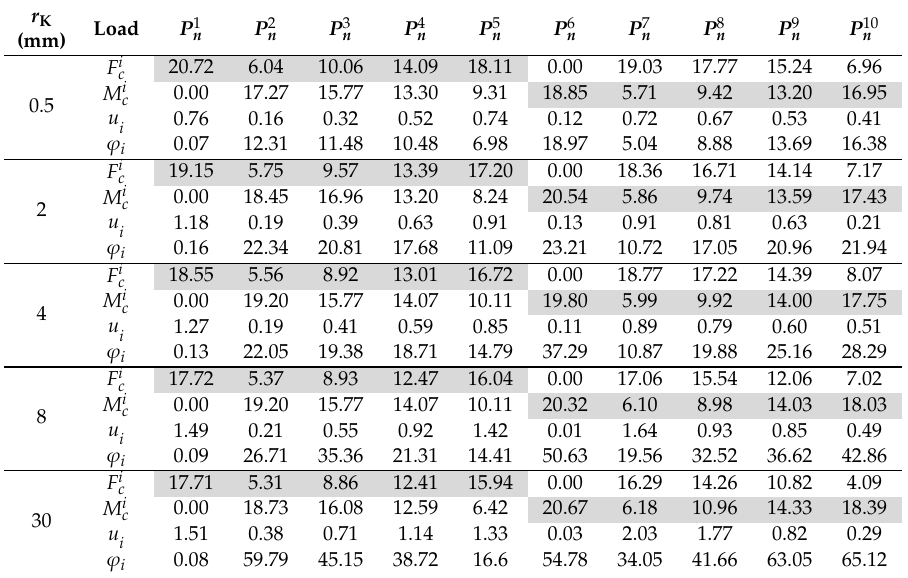
Table 4. Results of fracture for specimens with notches under non-proportional load.